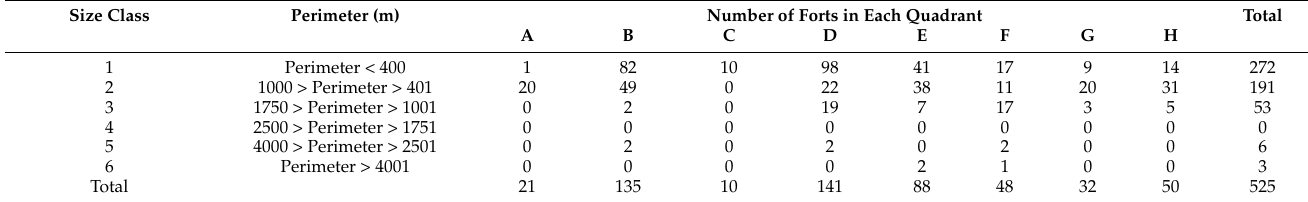
Table 2. Number of forts in each size classes by quadrant.